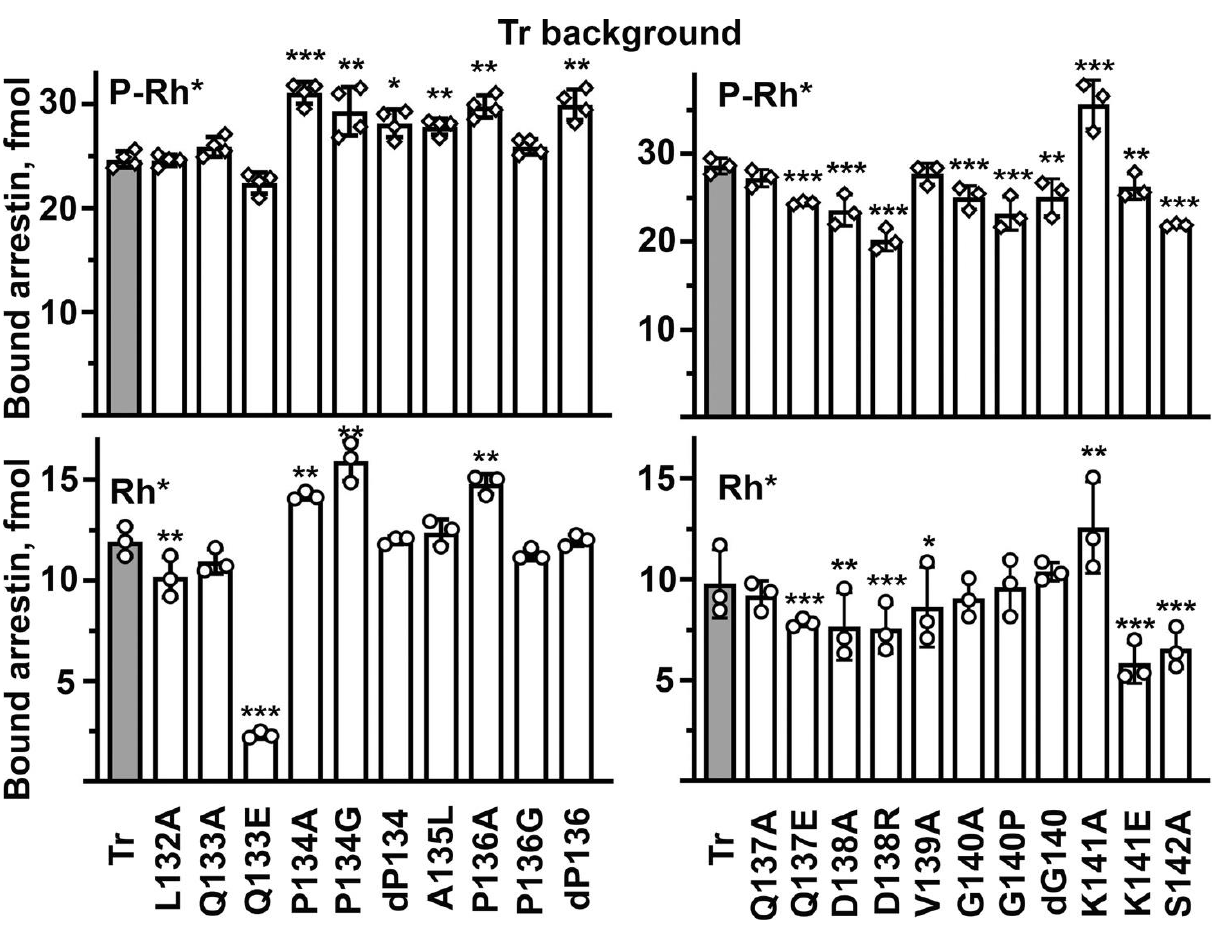
Figure 4. The effect of middle loop mutations on Tr background on arrestin-1 binding to rhodopsin. The binding of indicated mutants of arrestin-1 to P-Rh* and Rh* was determined using radiolabeled arrestins, produced in cell-free translation, in the direct binding assay with purified phosphorylated or unphosphorylated light-activated bovine rhodopsin, as described in Methods. Circles represent individual measurements performed in duplicate ( n = 3). The binding to P-Rh* and Rh* was analyzed separately in each of the two groups. Statistical significance of the differences between the parental Tr (darker shaded bars) and the arrestin-1 mutants was determined by ANOVA and Dunnet post hoc test and is indicated as follows: * p < 0.05; ** p < 0.01; *** p < 0.001 to Tr.